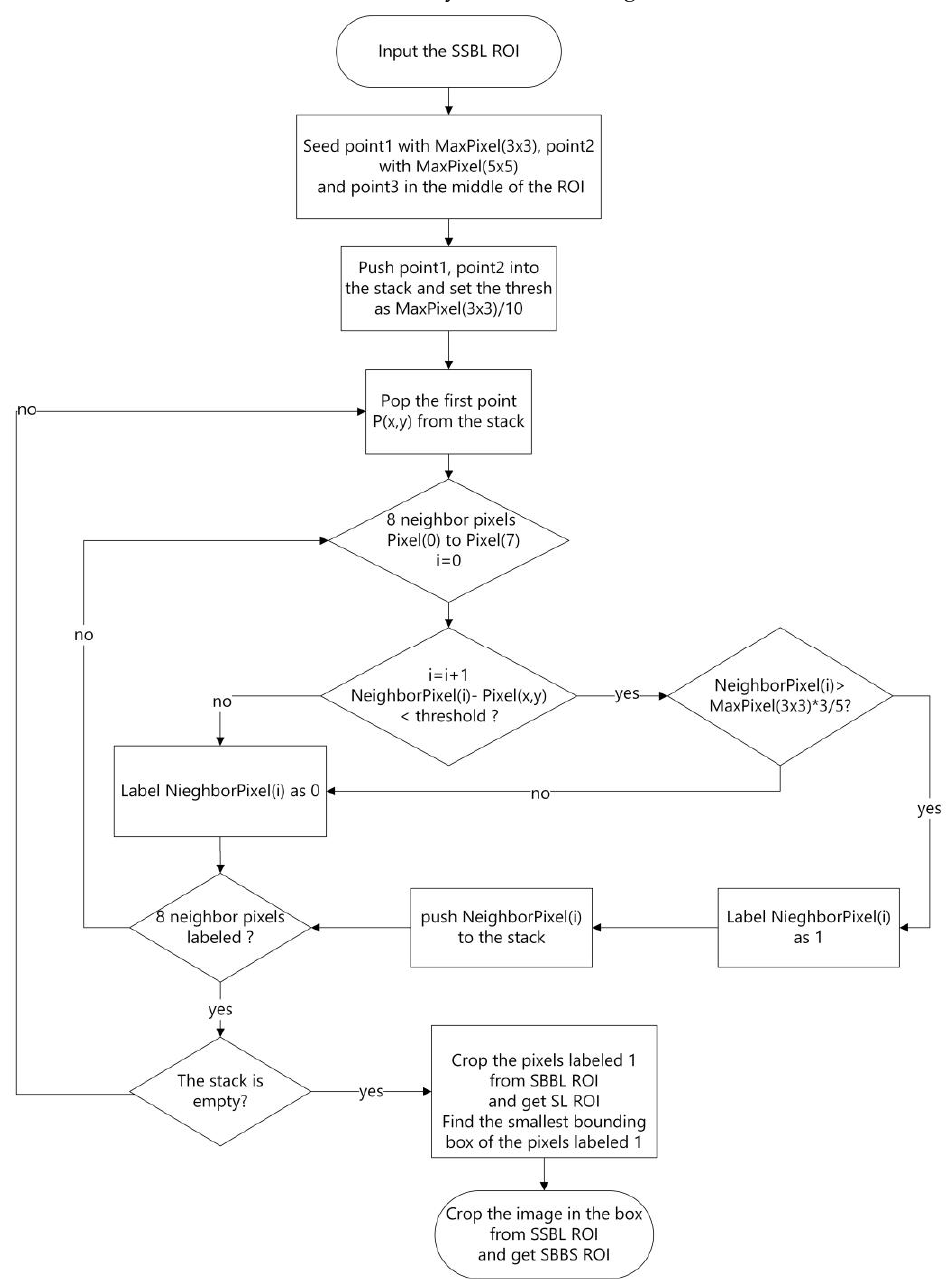
Figure 2. The flow of the SBBS-ROI extraction. * represents multiplication operation.